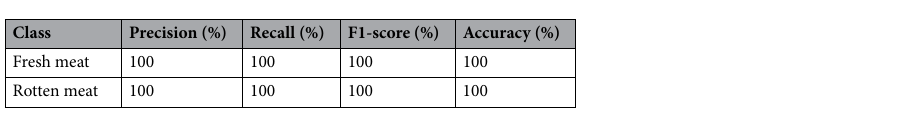
Table 4. The model evaluation result.